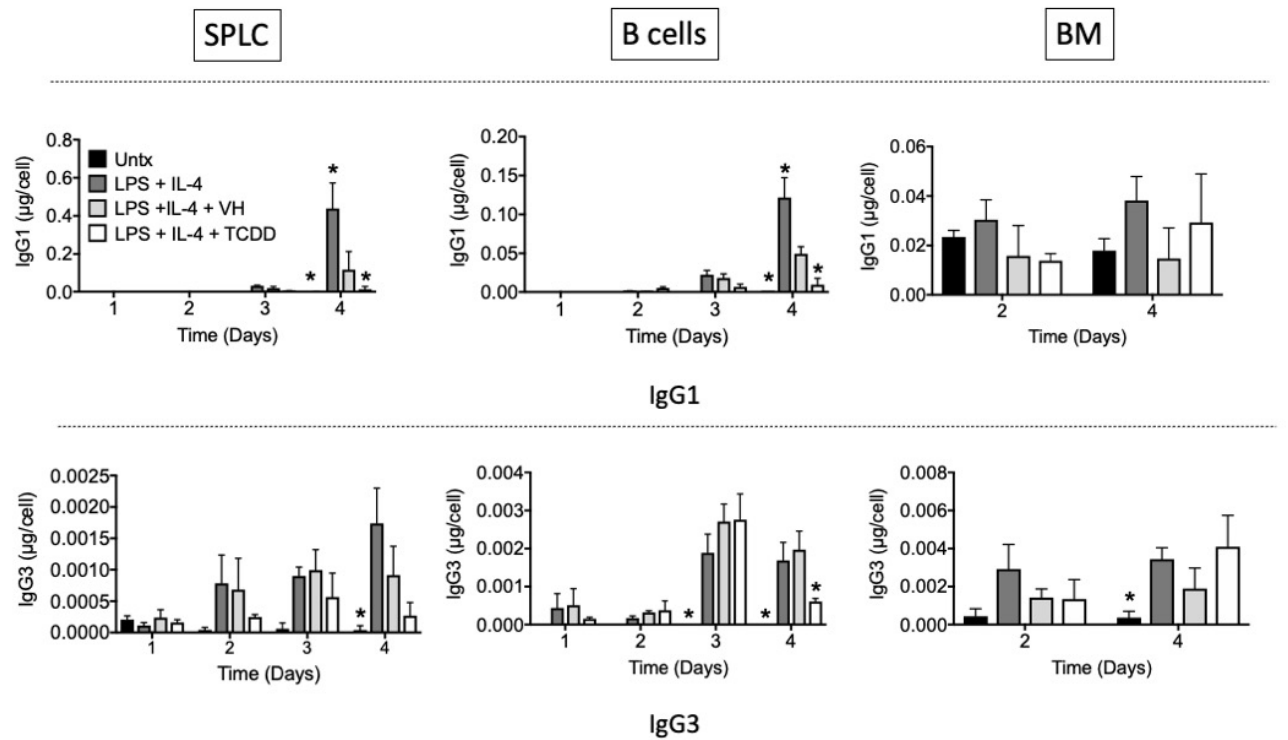
Figure 13. TCDD inhibited IgG1 and IgG3 antibody secretion. SPLC, B cells or BM cells were treated with VH (0.01% DMSO) or TCDD (30 nM) for 30 min then were stimulated with LPS + IL-4 (5 µg/mL + 10 ng/mL). Cells were incubated for 1, 2, 3 or 4 days then supernatants were collected and assayed by ELISA (top, IgG1; bottom, IgG3). Antibody levels were quantified as a concentration compared to a standard curve then normalized based on cell counts obtained from the Novocyte flow cytom- eter on each day. Bars represent mean ± SD from triplicate samples. Untx, untreated; VH, vehicle. * p < 0.05 as compared to respective LPS + IL-4 + VH control within day.